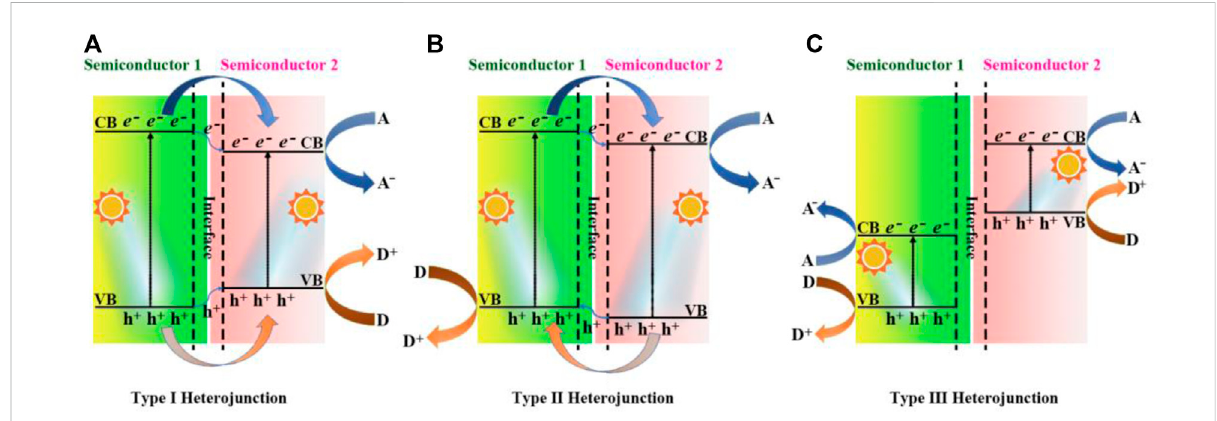
FIGURE 5 Schematic representation band structure of different heterojunctions: (A) Type Ⅰ heterojunction; (B) Type Ⅱ heterojunction; (C) Type Ⅲ heterojunction. A and D represent electron acceptor and electron donor, respectively.